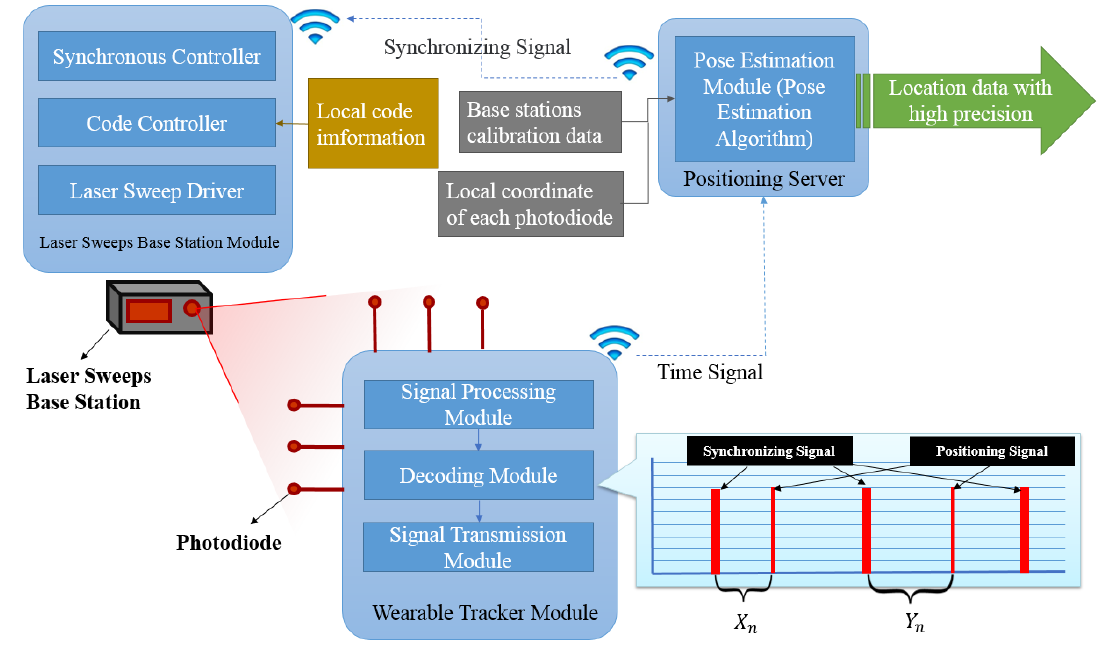
Figure 1. System functional diagram.